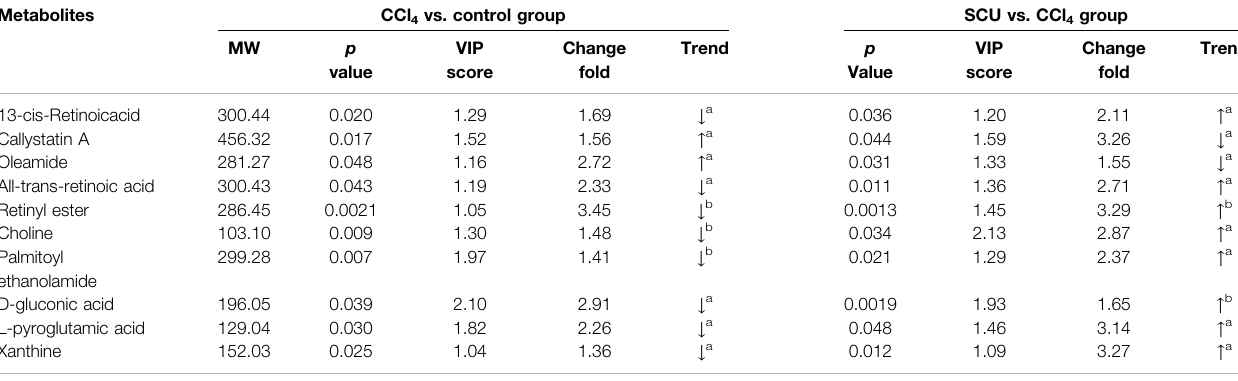
TABLE 3 | Altered metabolites in liver tissues among the control, CCl4, and the SCU group. Metabolites